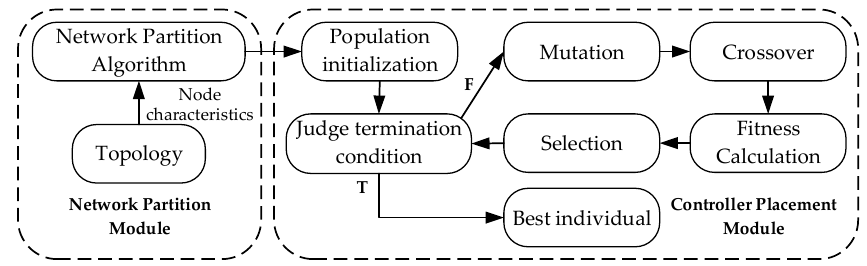
Figure 1. MODECP Approach.